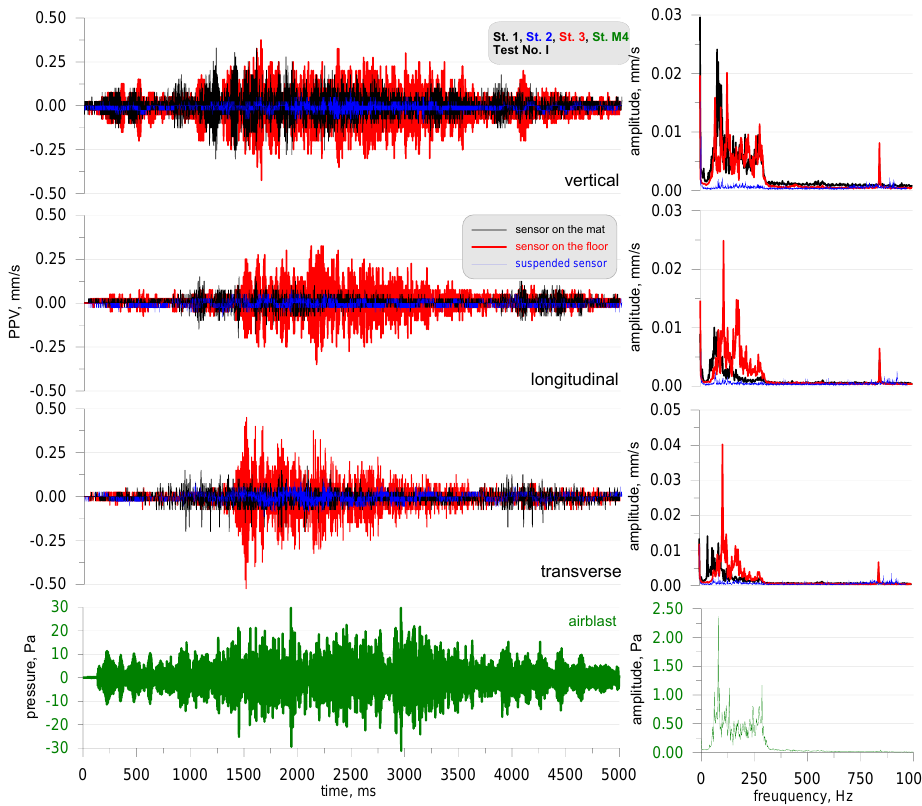
Figure 7. Test No. I: vibration seismogram (three directional components) and airblast pressure record with FFT analysis; sine sweep in the range of 30–300 Hz; stands 1, 2 and 4.